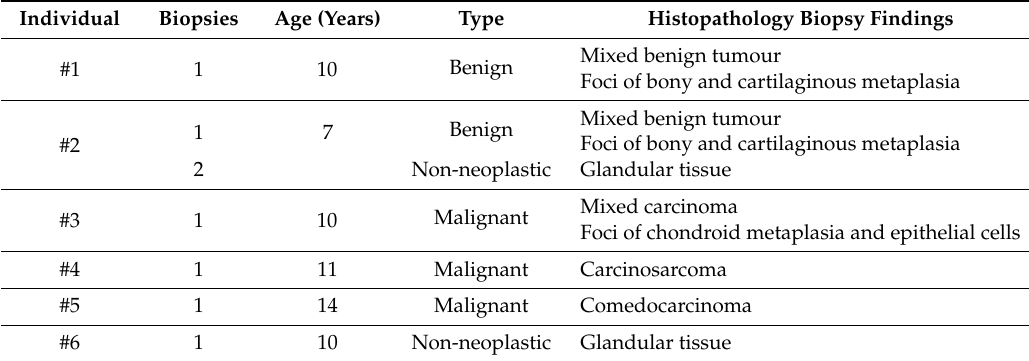
Table 1. Identification of the samples under study and results of histopathological